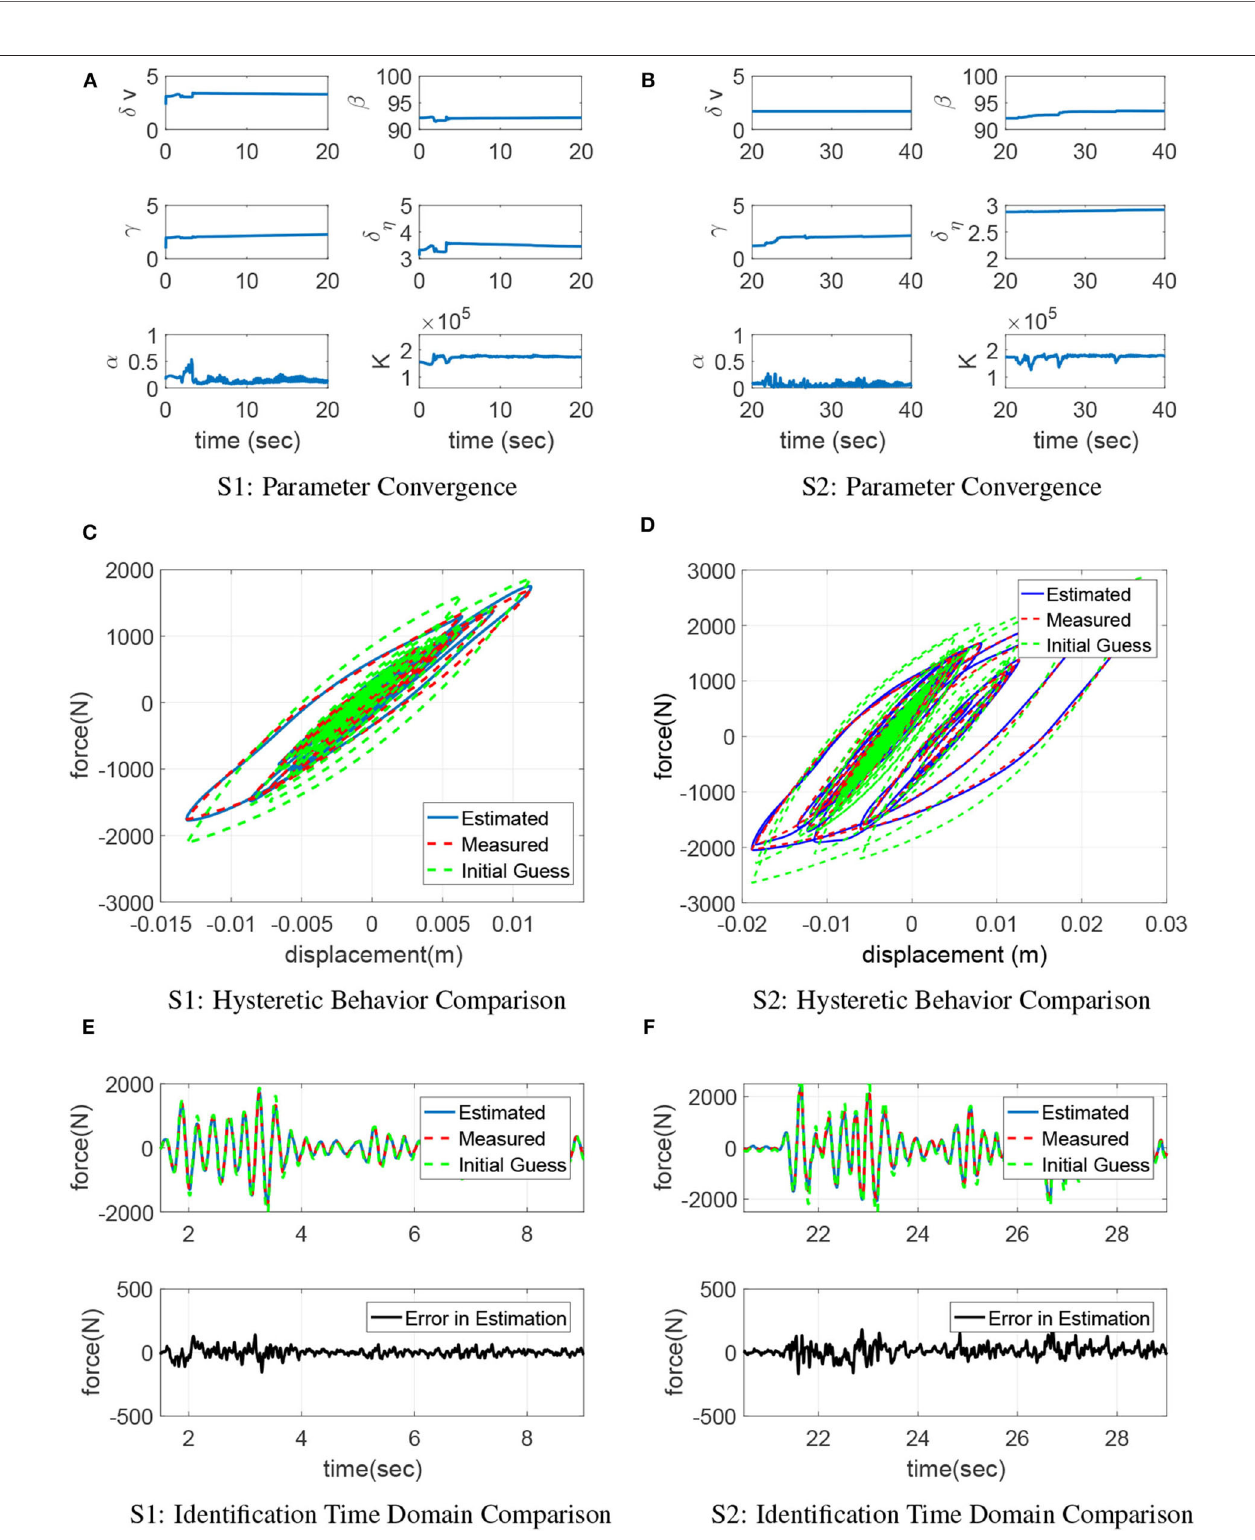
FIGURE 4 | Model updating performance using Bouc-Wen model. (A) S1: parameter convergence, (B) S2: parameter convergence, (C) S1: hysteretic behavior comparison, (D) S2: hysteretic behavior comparison, (E) S1: identification time domain comparison, (F) S2: identification time domain comparison.